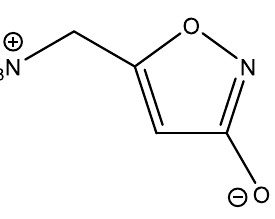
Figure 26. Muscimol. Figure 26.